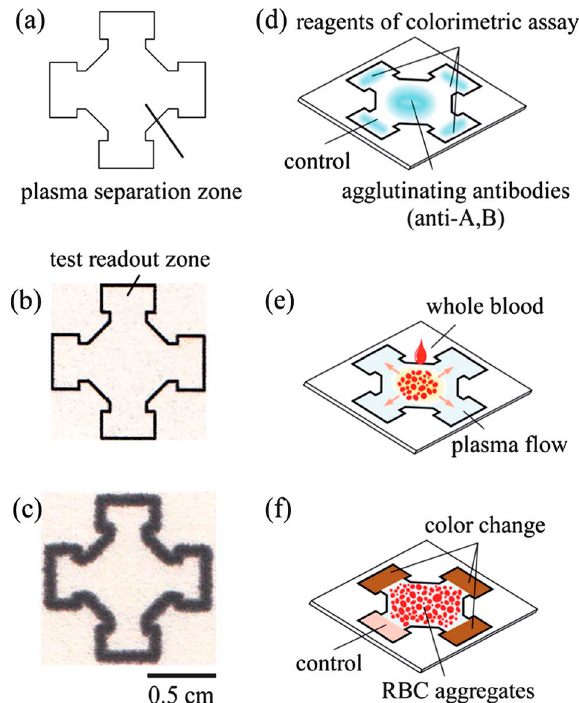
Figure 3. Fabrication scheme of the μ PAD designed in [91]. The central plasma separation zone ( a ) and the four test readout zones ( b ) were patterned on chromatography paper by a wax printer ( c ). ( d ) Agglutinating antibodies were immobilized at the central part while the reagents for the colorimetric assay at the periphery zones. ( e ) To perform a diagnostic test with the developed μ PAD, the whole blood sample was dropped onto the plasma separation zone. ( f ) The red blood cells were agglutinated in the central zone, while the separated plasma wicked into the test readout zones and reacted with the reagents of the colorimetric assay. With the permission from [91]; Copyright 2012, The Royal